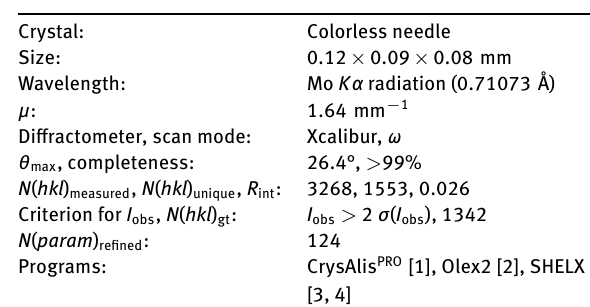
Table 1: Data collection and handling.